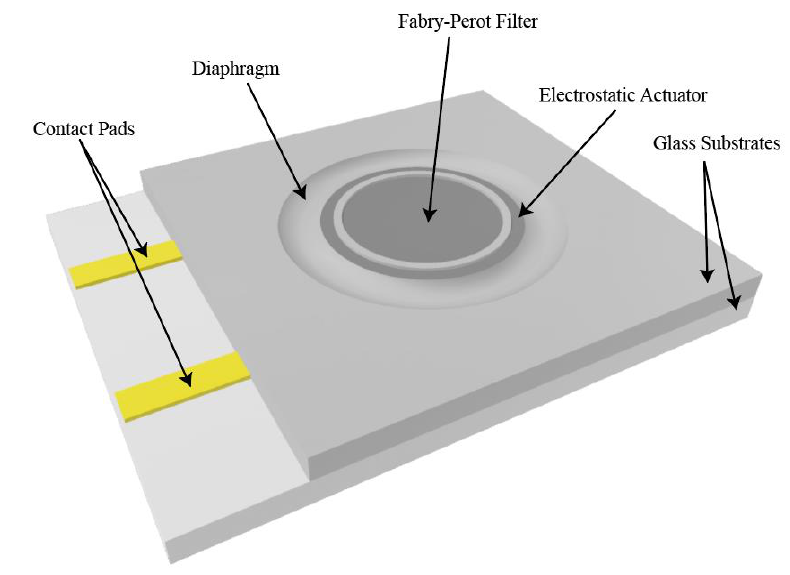
Figure 1. Schematic representation of the MEMS chip.